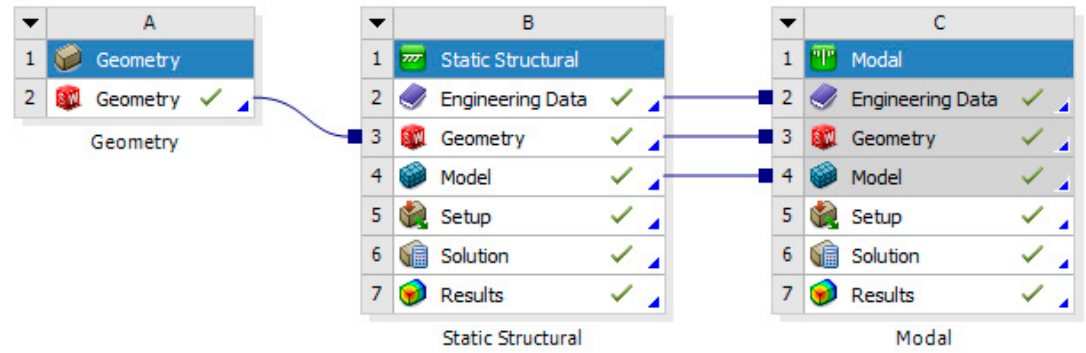
Figure 18. Process of the finite element analysis.